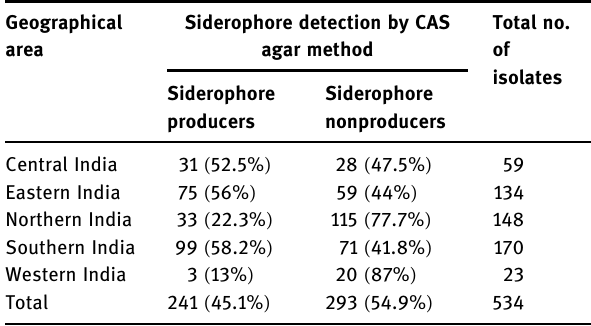
Table 1: Region - wise distribution of siderophore - producing E.